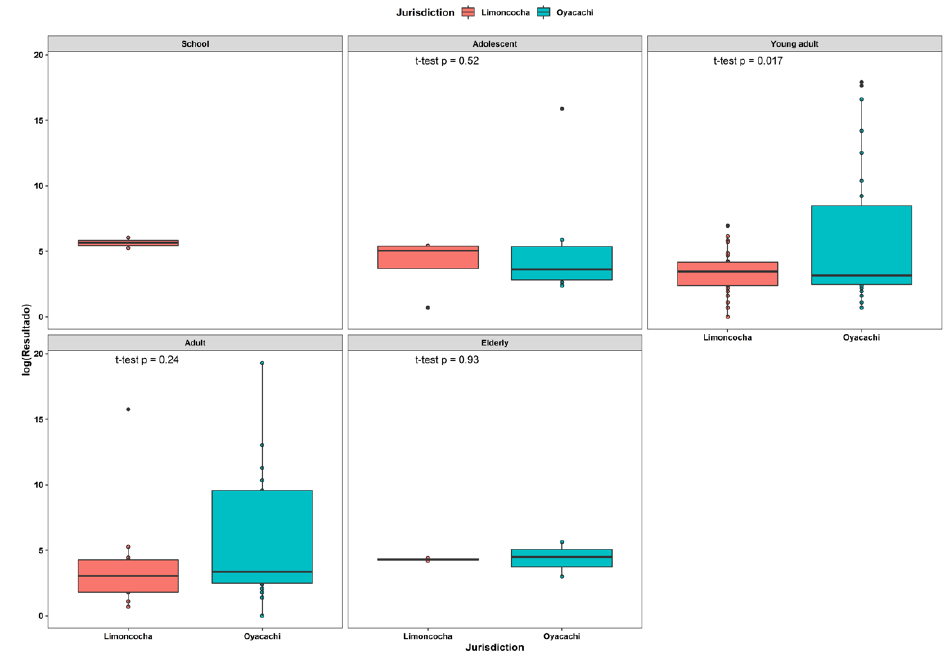
Figure 4. Box plot of viral load composition across age groups among 108 positive tests for SARS- CoV-2 infection. Age groups classification is according to the United Nations guidelines as follows: school (<12 years), adolescent (13 – 20 years), young adult (21 to 39 years), adult (40 to 64 years), and elderly (>65 years).